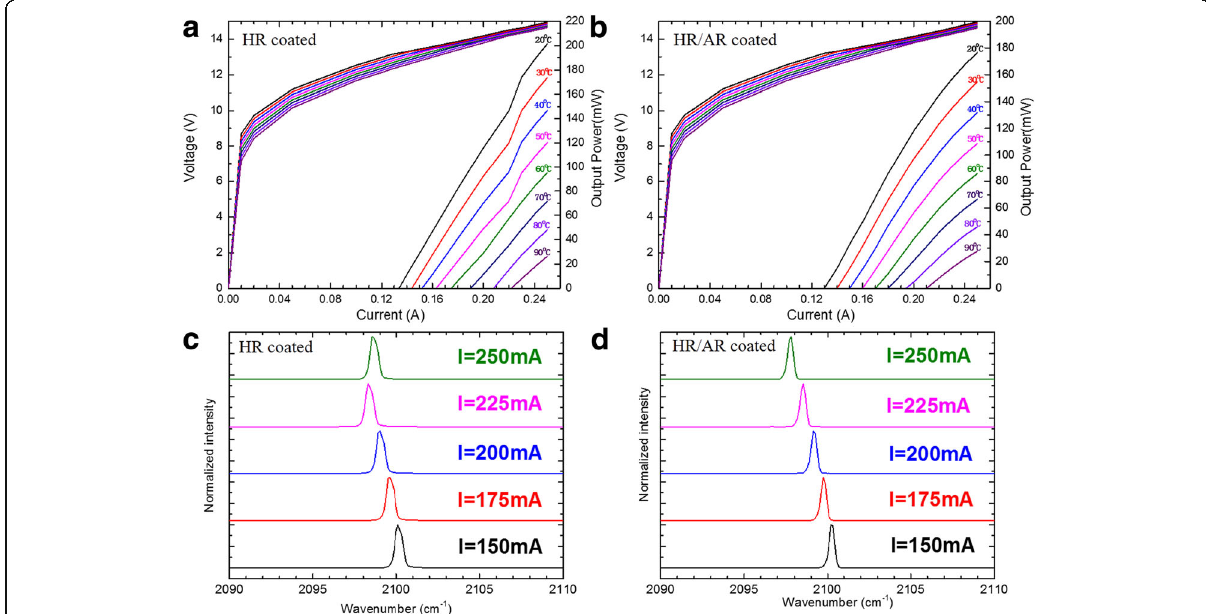
Fig. 4 a , b Output power versus current of the DFB laser operated in CW mode at different heat sink temperatures between 20 and 90 °C along with V - I curves. c , d CW lasing spectra at different currents from 150 to 250 mA with a step of 25 mA at 20